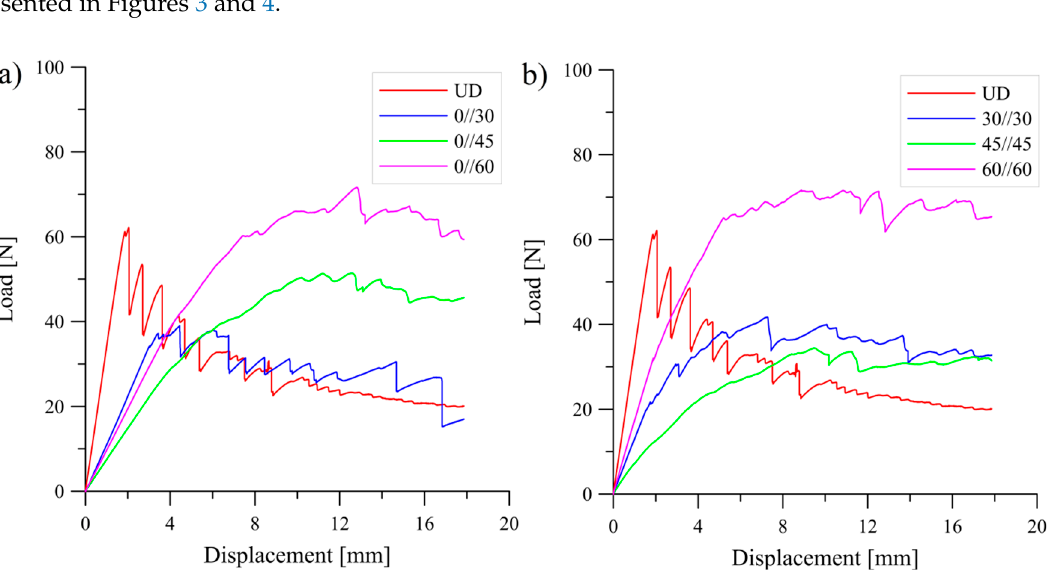
Figure 3. Load-displacement curves obtained during the DCB experiments: ( a ) for the UD and the 0°// θ laminates, ( b ) for the UD and the θ // θ laminates.